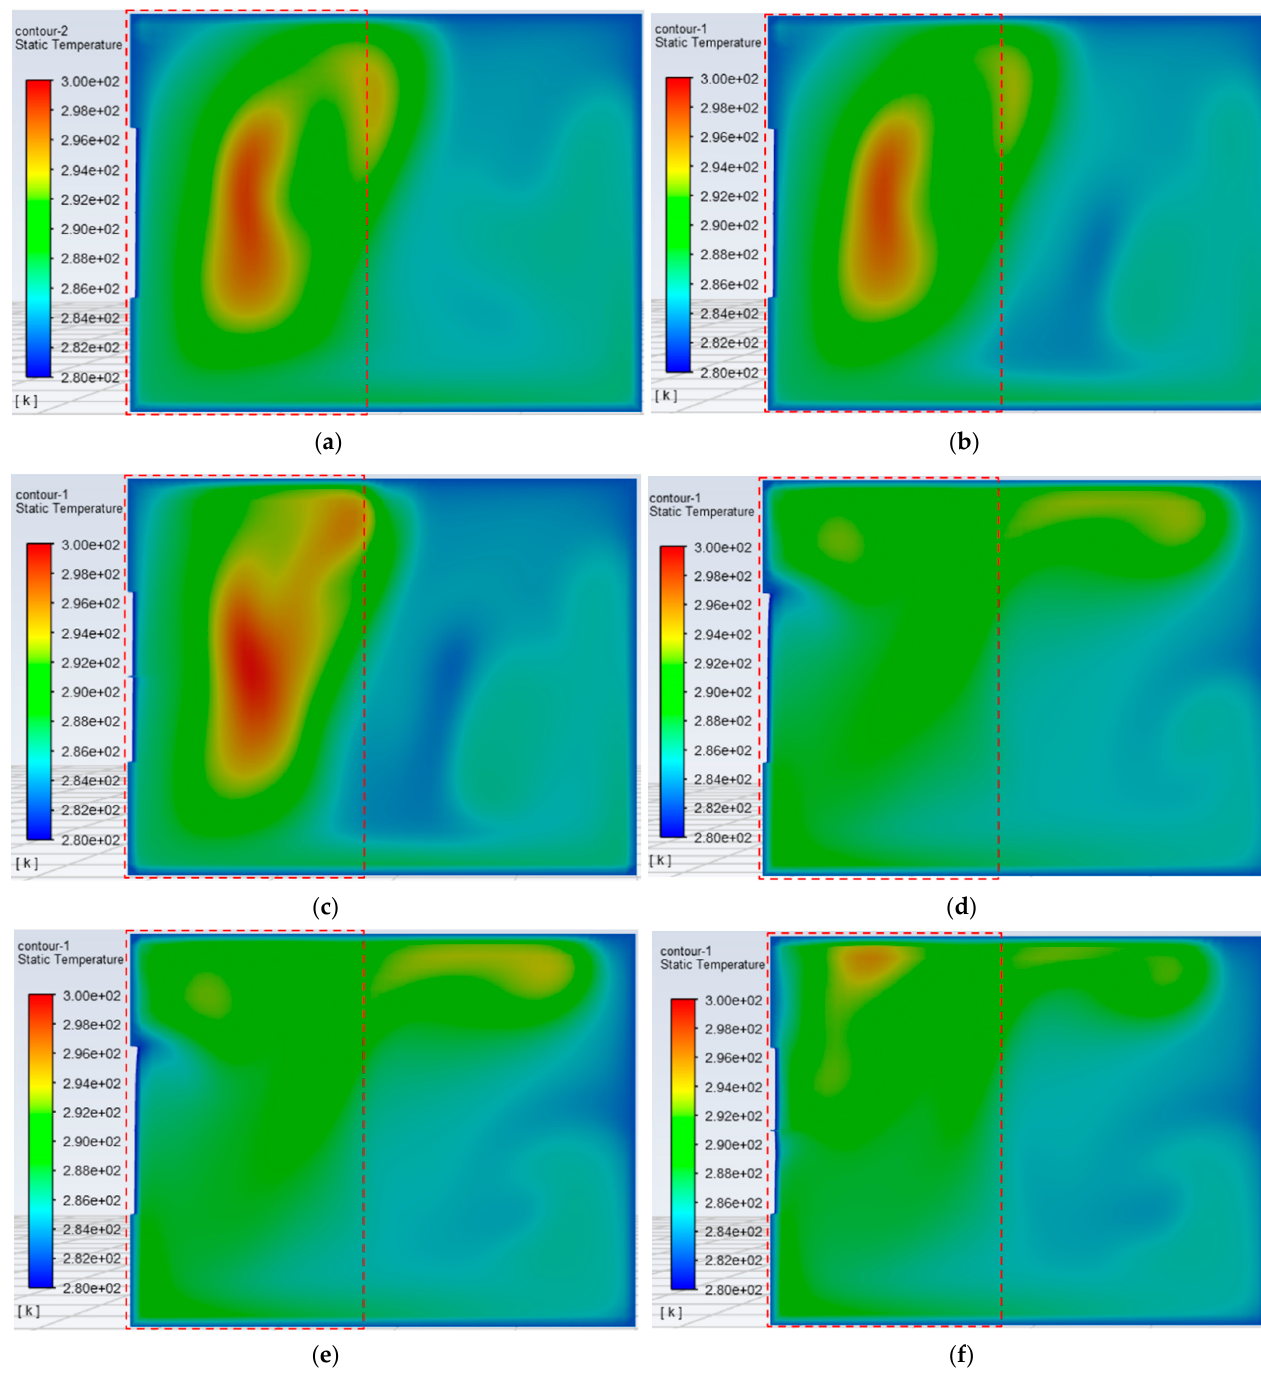
Figure 16. Contours of indoor 1.2m high plane temperature distribution under six schemes: ( a ) MOUSLE, ( b ) MSUSLE, ( c ) MUSEWP, ( d ) DOUSLE, ( e ) DSUSLE, ( f ) DUSEWP.